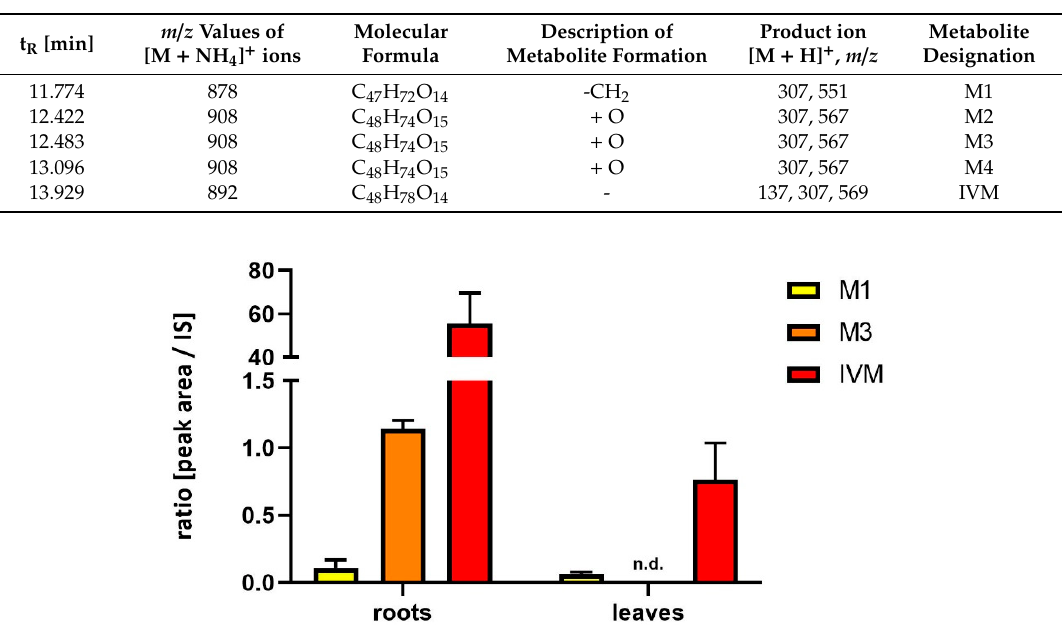
Table 1. Description of the metabolites of ivermectin (IVM) present in Glycine max detected by UHPLC-MS / MS.